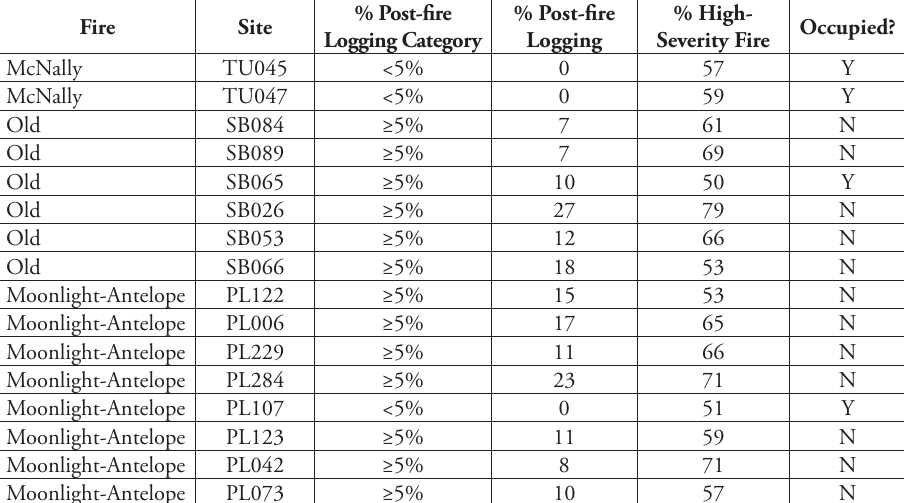
Table 3. Occupancy of California spotted owl sites with 50-80% high-severity fire. Sites have varying levels of post-fire logging, within a 1500 m radius of territory centres, in large fires >10,000 ha in size since 2001. Within each fire, all sites were occupied in a single survey year prior to post-fire